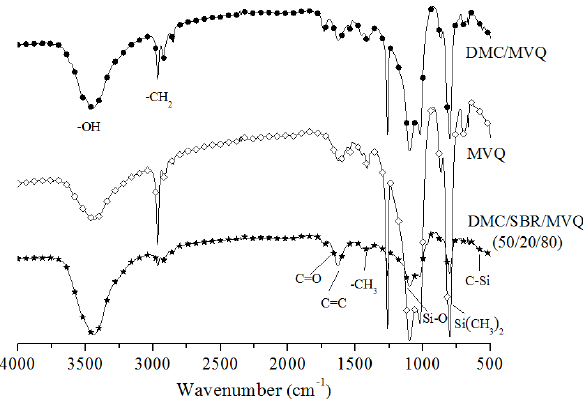
Figure 2: FTIR spectra of DMC/SBR/MVQ